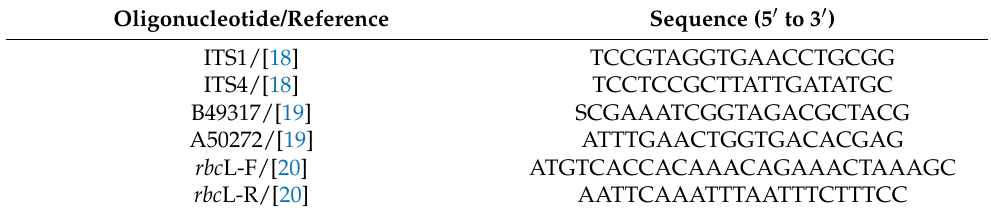
Table 1. Oligonucleotides used for PCR and sequencing of ITS, trn F- trn L (B49317-A50272) and rbc L, for wild Mexican B. monnieri